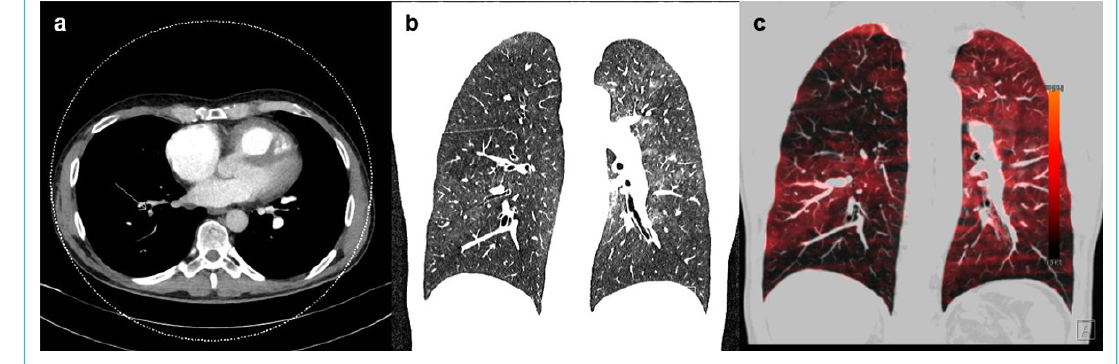
Figure 11: Dual-energy computed tomography (CT). (a) Contrast-enhanced CT axial reconstruction demonstrating a dilated right atrium, and narrowing of the pulmonary arteries of the right side by thromboembolic material; (b) contrast-enhanced CT coronary reconstruction with mo- saic perfusion pattern; (c) dual-energy CT scan showing iodine mapping of unmatched perfusion defects. (Courtesy of Prof. T.